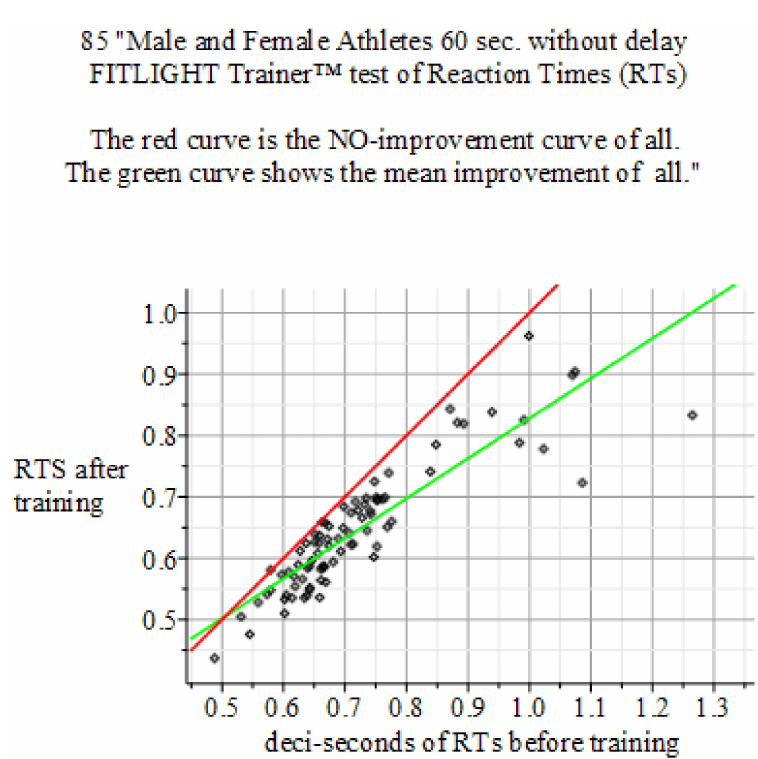
Figure 4. Summary of the above result: Reaction Times: 60 s without delay FITLIGHT Trainer™ equipment. Sample size of 85 men and women. Baseline sample mean 0.721 s, σ = ± 0.1075, and Final mean 0.646 s with σ = ± 0.0989. P -value 0.0000914155. Result: Hypothesis of NO-Effect of training is: